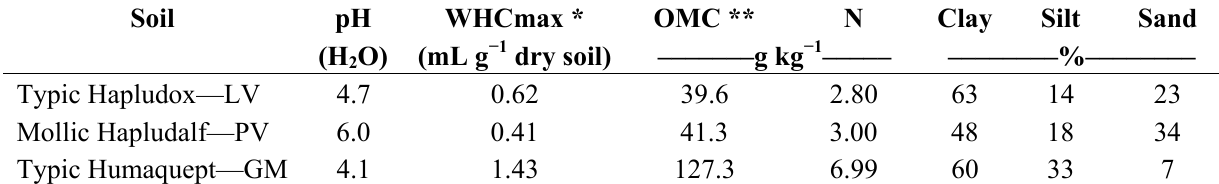
Table 1. Main properties of the soils used for determining the avoidance of earthworms Eisenia andrei to treatments with